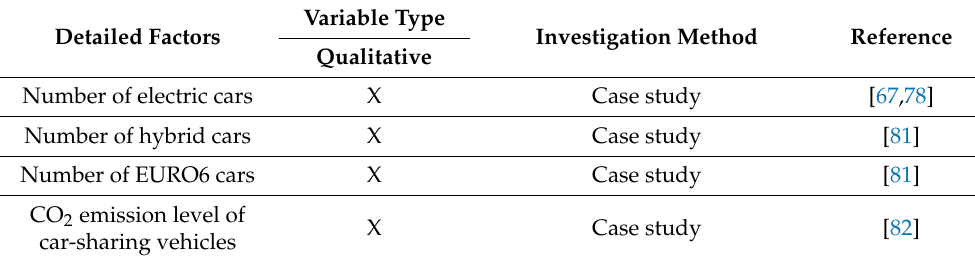
Table 12. Factors related to environmental issues associated with the car-sharing fleet.